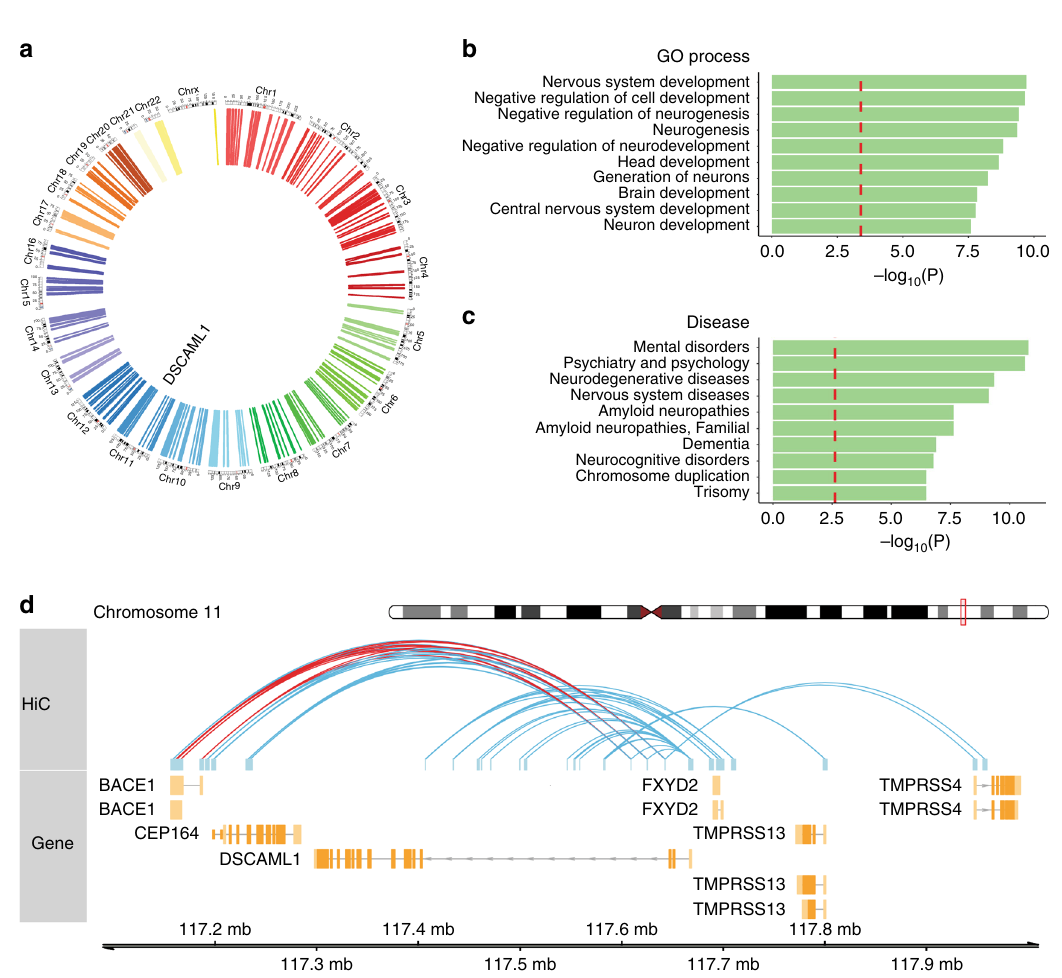
Fig. 2 Chromatin conformation analysis in cortical neurons identifying the gene targets of the differentially methylated enhancers in AD. Chromatin interactions, genome-wide, were determined using Hi-C data from human prefrontal cortex. a Circos plot showing signi fi cant interactions between differentially methylated enhancers in AD neurons and gene promoters (TSS ± 2 kb). AD enhancers acted in cis for all their target gene promoters (average 587 kb ± 37 kb enhancer – target promoter distance; n = 1224 enhancers). b , c Pathways affected by genes with differentially methylated enhancers in AD, as determined by MetaCore. Top ten GO processes and disease pathways show that in our unbiased, genome-wide analysis, the enhancers dysregulated in AD neurons affected genes involved in neurogenesis and amyloid neuropathies ( q < 0.05, hypergeometric distribution; red dashed line). d Chromatin interactions of the enhancers in DSCAML1 that were differentially methylated in AD neurons (all interactions ± 400 kb of DSCAML1 shown). Enhancers in DSCAML1 targeted the promoters of BACE1 (shown in red) as well as other